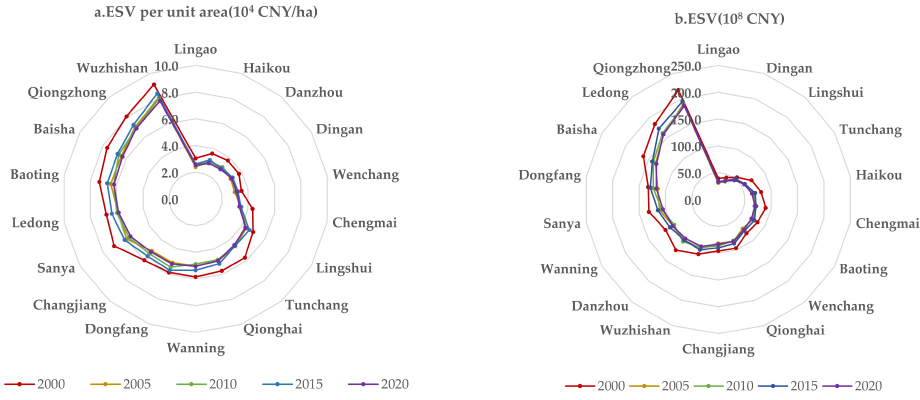
Figure 9. ESV and ESV per unit area change in 18 cities from 2000 to 2020. ( a ) ESV per unit